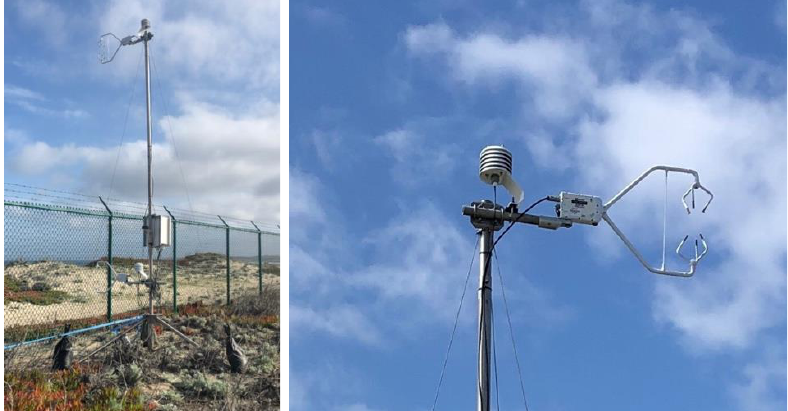
Figure 1. Sensor platform ( left ) and close-up of two of the sensors ( right ). The upper sensor is a HygroVUE5 hygrometer, and the one on the right is a CSAT3 sonic anemometer. HygroVUE5 hygrometer, and the one on the right is a CSAT3 sonic